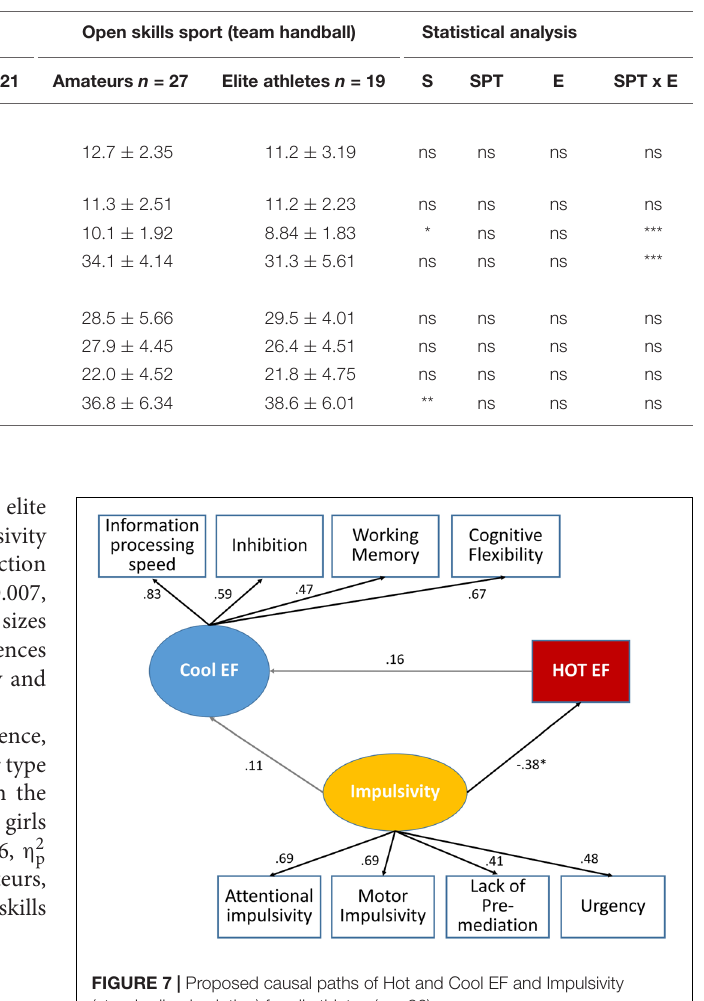
TABLE 2 | Group differences in impulsivity measures.